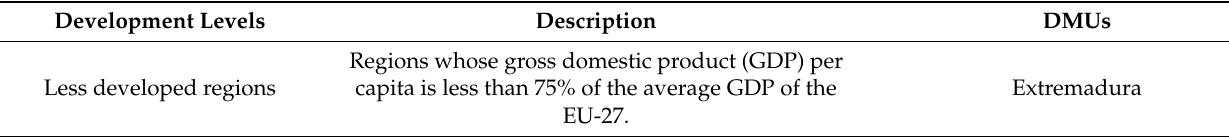
Table 4. DMUs used and level of development (Source: European Commission).